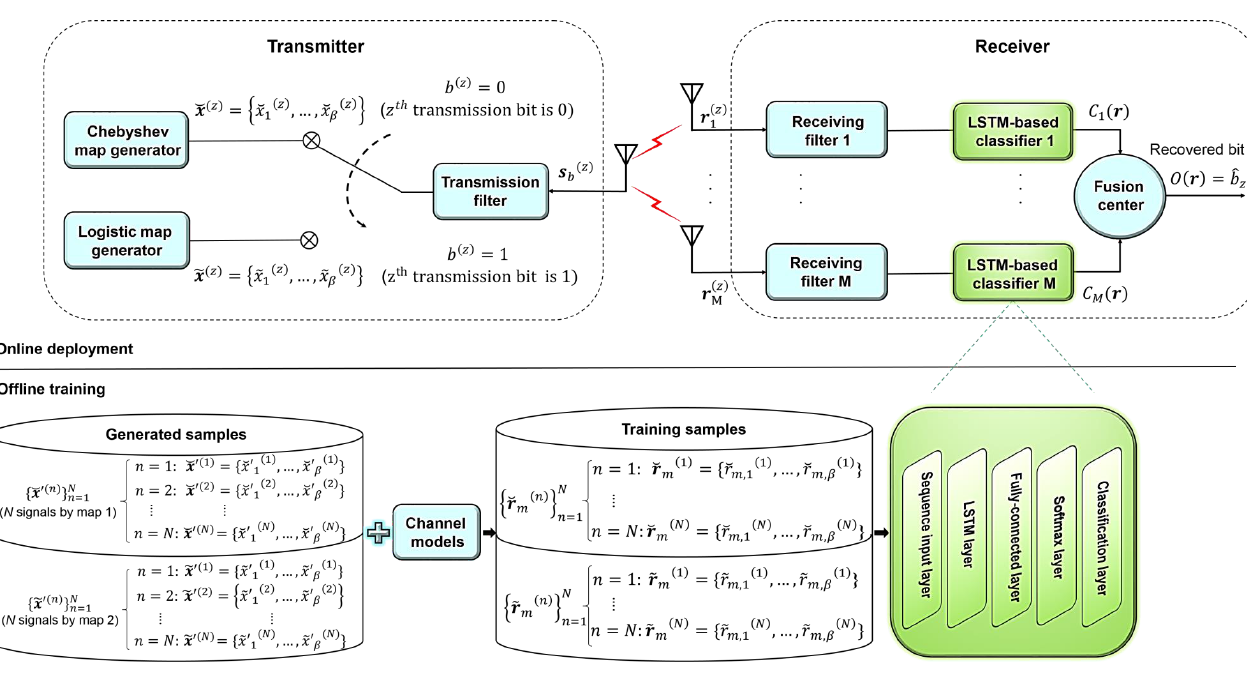
Figure 1. The SIMO DLCSK digital communication